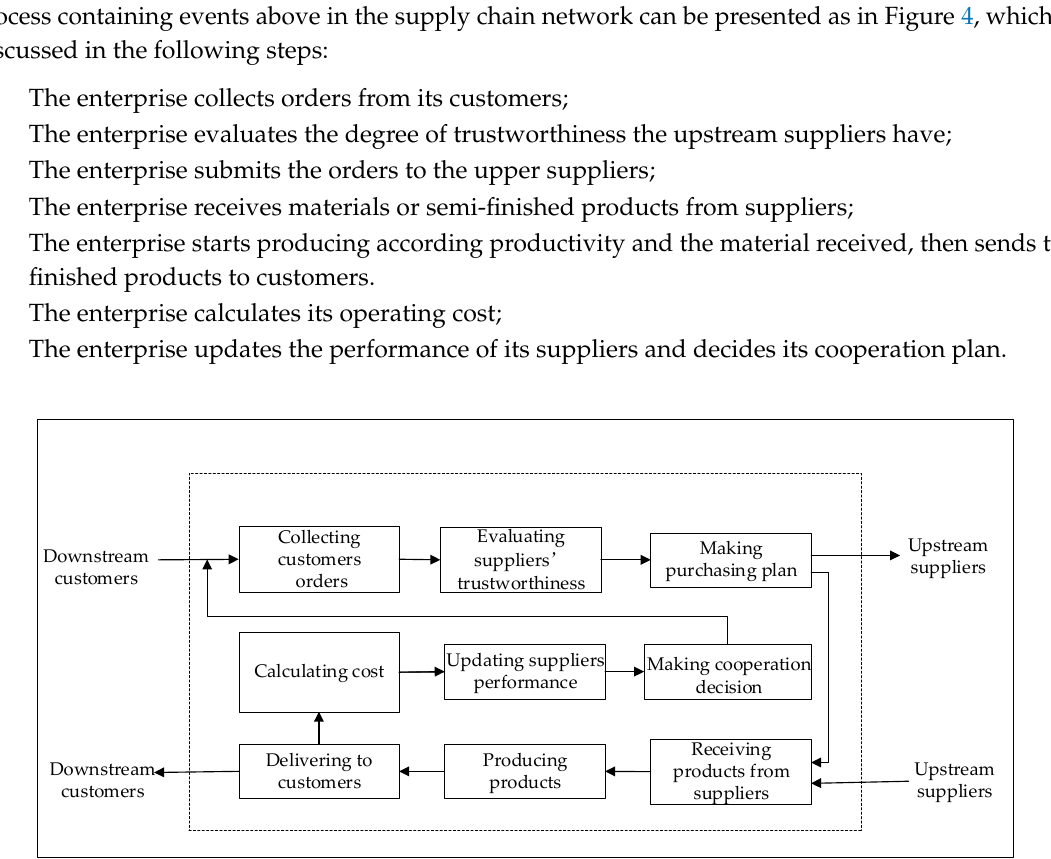
Figure 4. The events processing of an enterprise in the supply chain network.